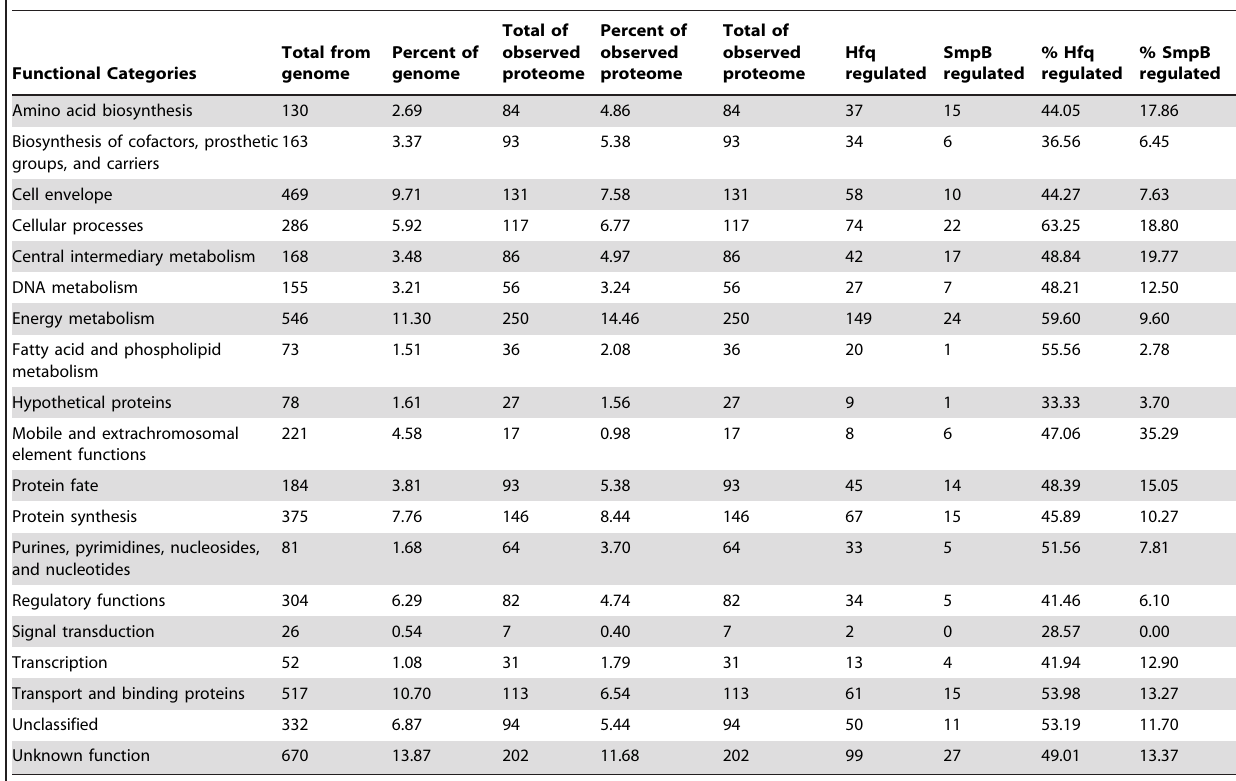
Table 1. JCVI functional categories for the entire annotated genome and characterized